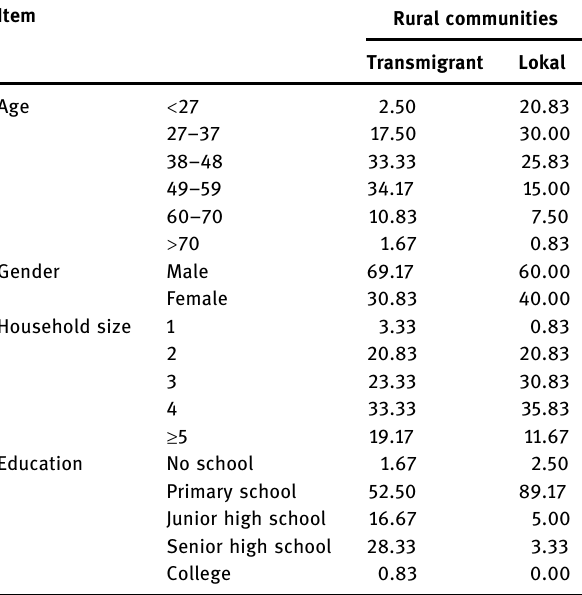
Rural communitiesItem